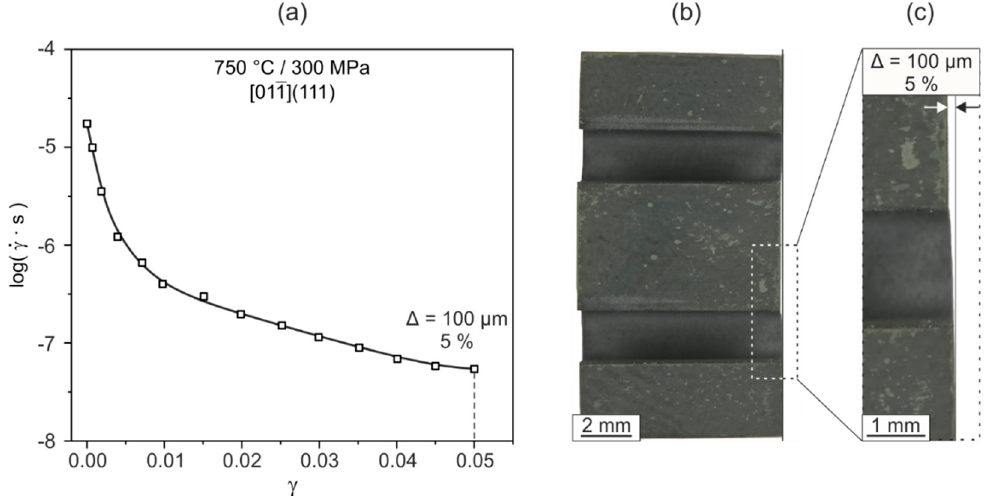
Figure 2. Shear creep displacements in the macroscopic crystallographic shear system [ 011 ]( 111 ) . ( a ) Creep curve presented as the logarithmic shear rate log( γ ) as a function of engineering shear γ . The experiment was interrupted at γ = 5% corresponding to a displacement of 100 µm. ( b ) and ( c ): Corresponding specimen after 5% shear creep deformation, and 100 µm shear displacement detected in the SEM.